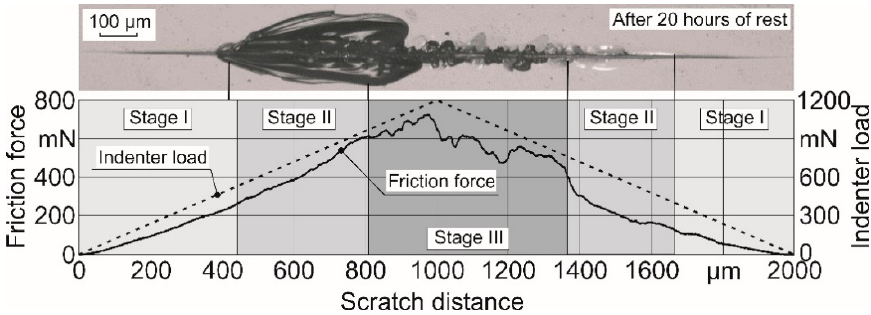
Figure 4. Tribogram and micro photo of the scratch in the glass light krone LK-5 by the progressive method.